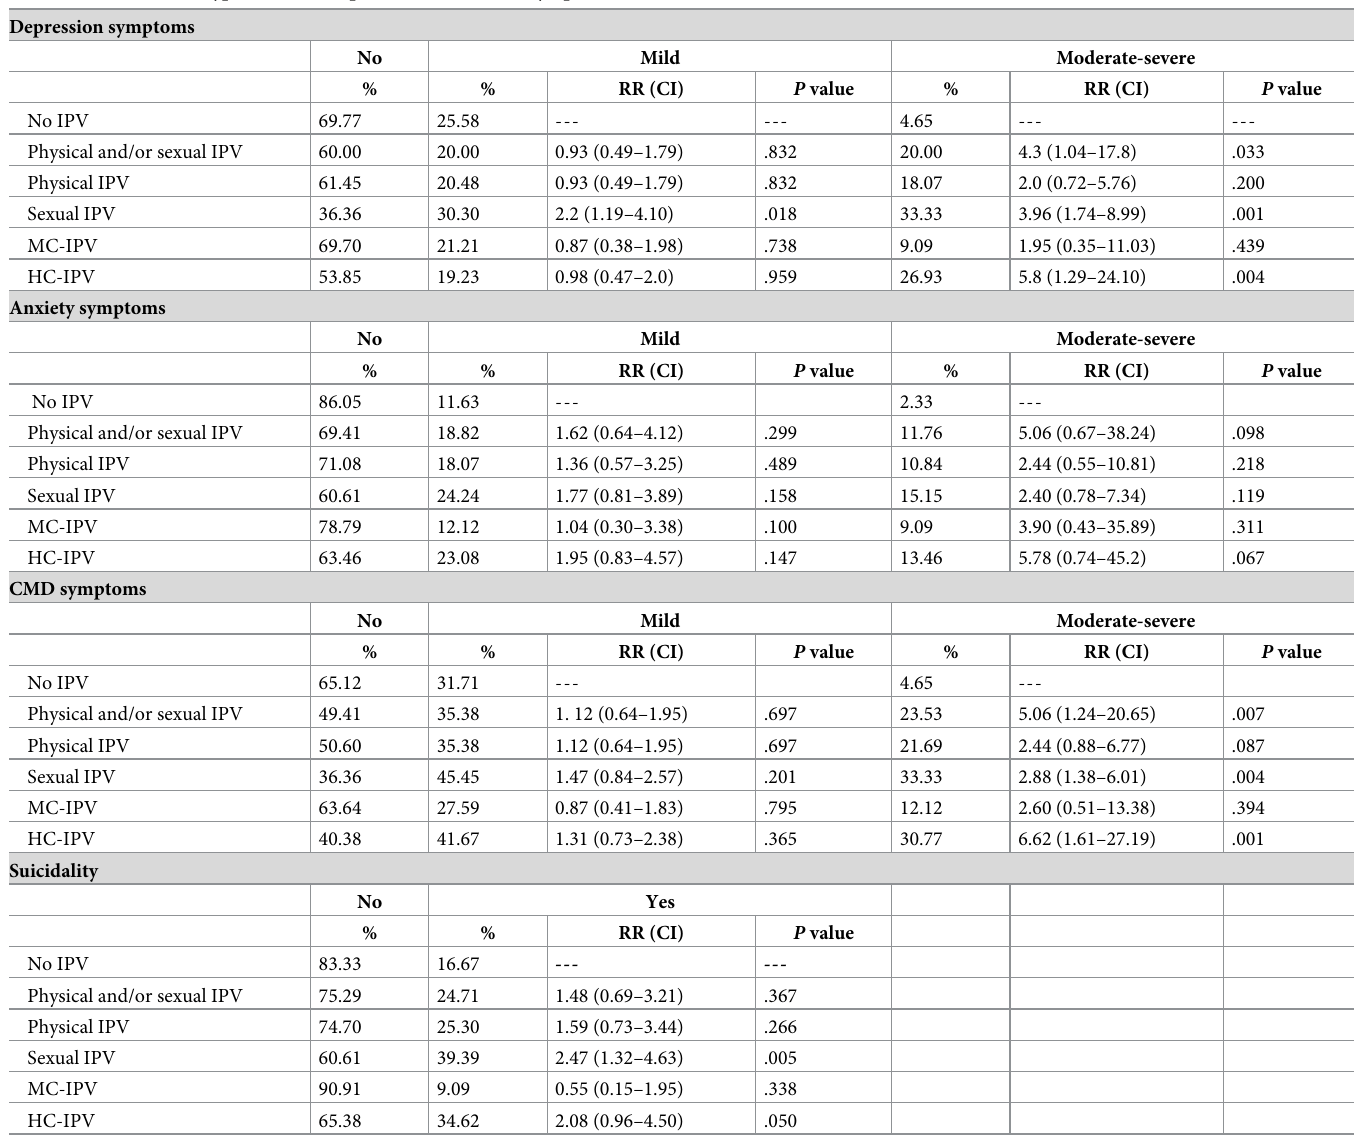
Table 4. Association of types of intimate partner violence with symptoms of CMD ( n =